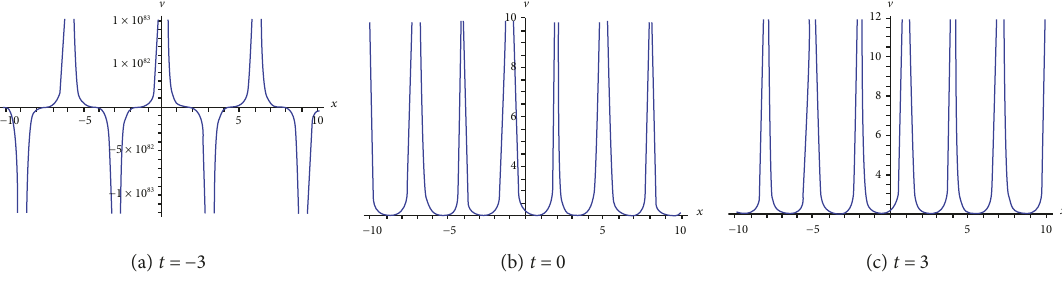
Figure 4: Nonlinear dynamical evolutions of solution (25) determined by (51).